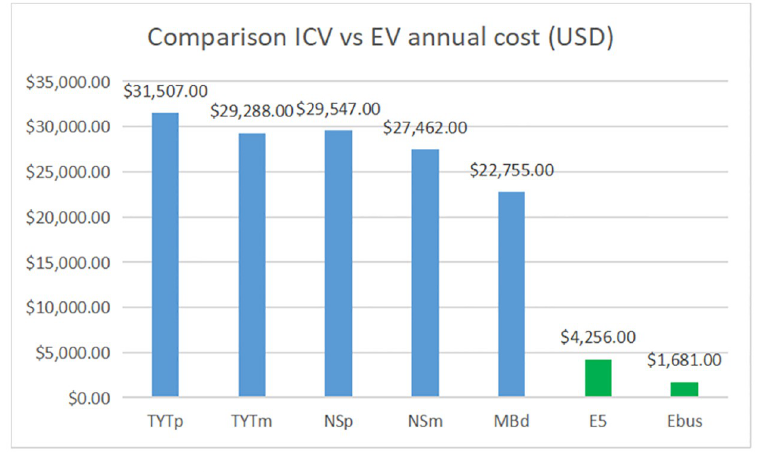
Fig 7. ICV vs EV annual